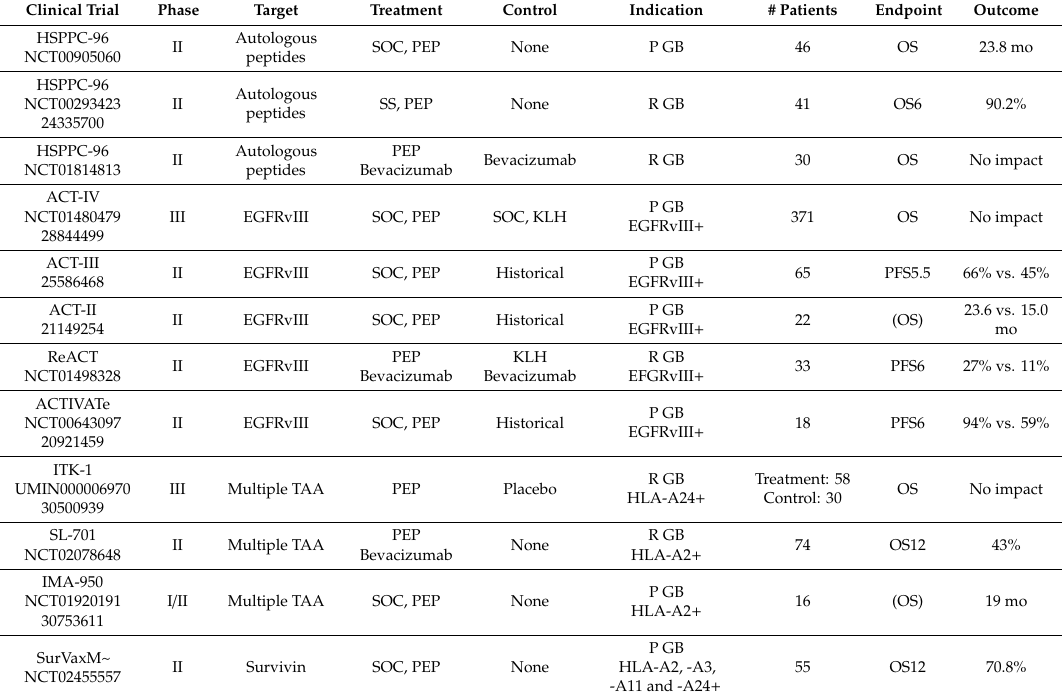
Table 2. Phase II / III clinical trials with peptide vaccines in